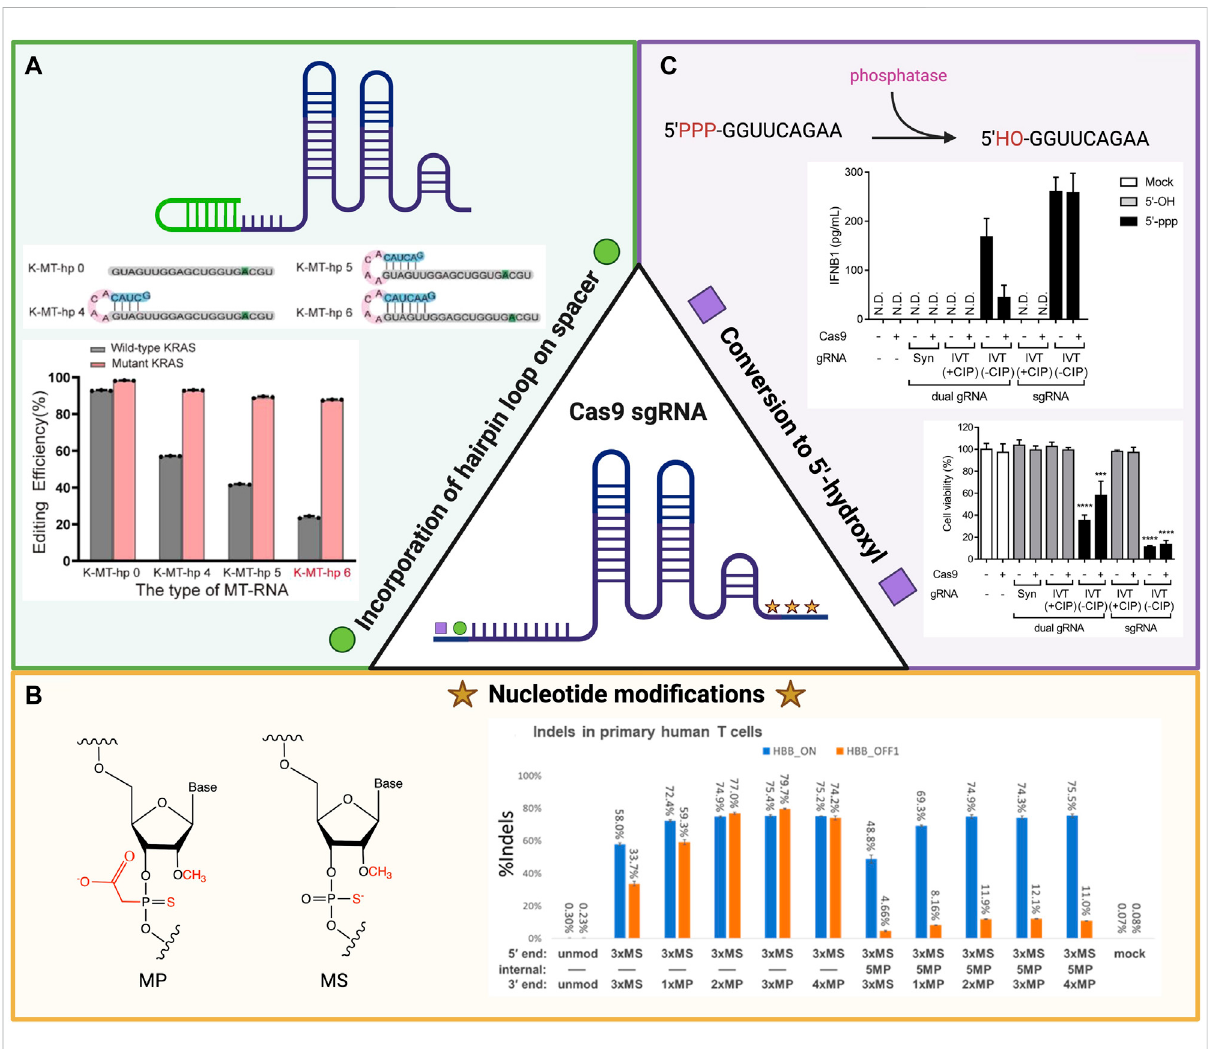
FIGURE 1 Schema of the chemical modi fi cations that affect Cas9 editing ef fi ciency and speci fi city of single guide RNA (sgRNA) to target sequences. (A) TheincorporationofhairpinloopsinsgRNAincreasestheselective invitro editingef fi ciencyofthemutantKRASgeneoverthewildtypeversionin comparison to linear sgRNA in MCF-7 cells. Image reused with permission from ref (Liang et al., 2022). Copyright 2022 American Chemical Society. (B) Speci fi c chemical modi fi cations (left) to nucleotides on both the 5 ′ and 3 ′ ends of synthesized sgRNA have increased on-target and off- target gene disruption in primary human T cells for the HBB gene (right). Image reproduced from ref (Ryan et al., 2022) with permission from American Chemical Society. License CC BY-NC-ND 4.0 https://creativecommons.org/licenses/by-nc-nd/4.0/. (C) Conversion of the 5 ′ - triphosphate group to a 5 ′ -hydroxyl group on the 5 ′ end of sgRNA through the addition of calf intestinal phosphatase has led to a decrease in IFNB1 immune response and increase in cell viability when transfected with Cas9 ribonucleoprotein (RNP). Image reproduced from ref (Kim et